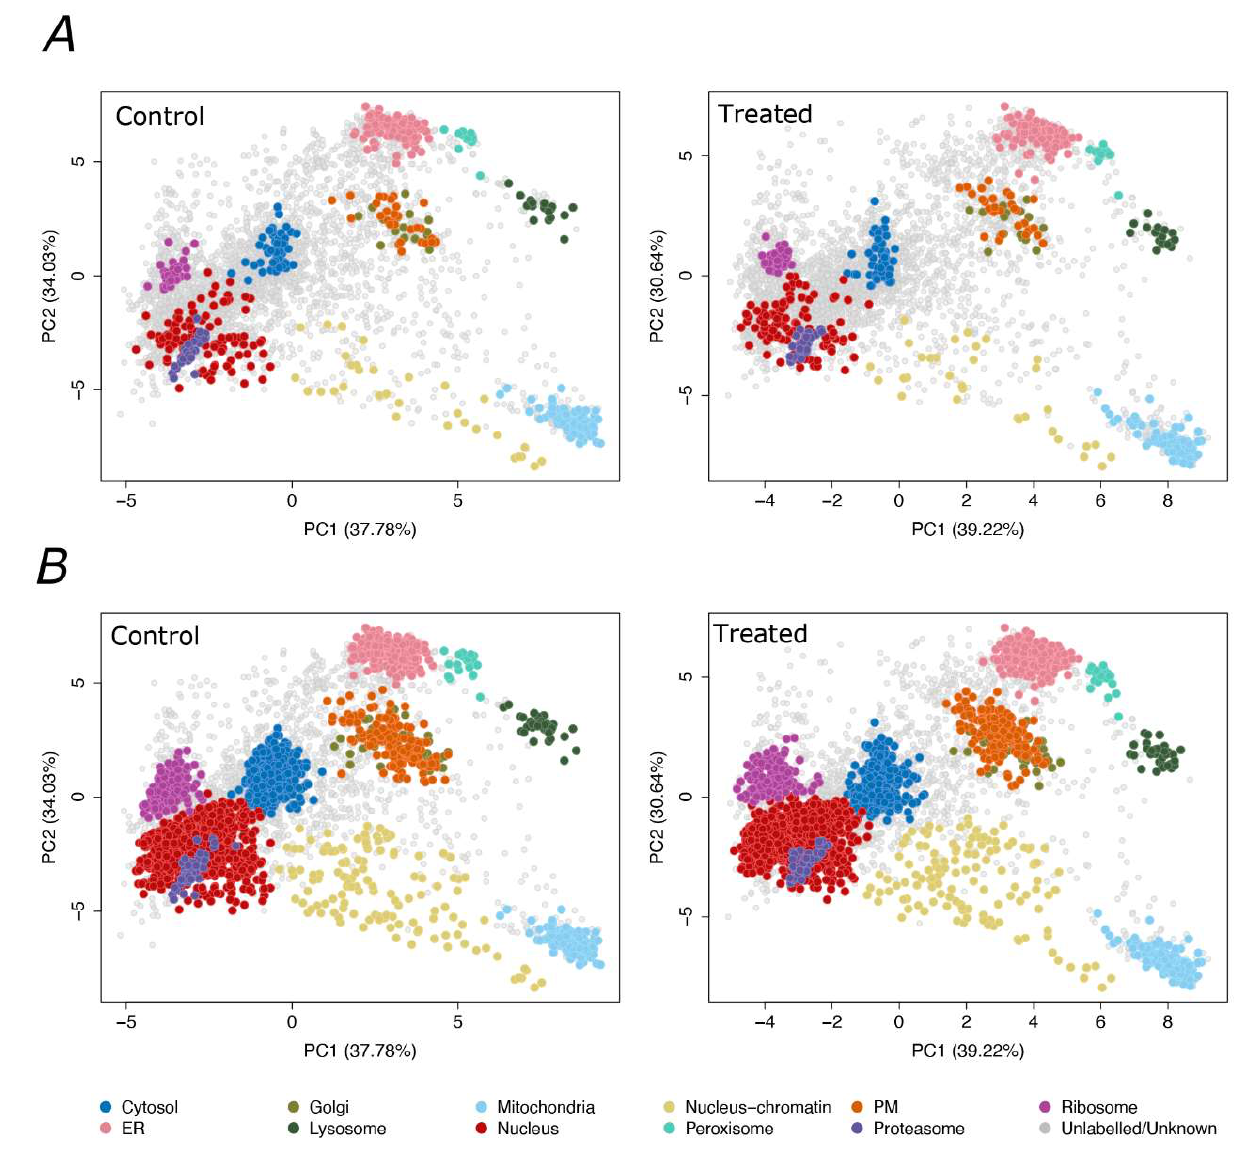
Figure 2. Subcellular maps of the F508del-CFTR CFBE41o- proteome. Each point corresponds to a single identified protein. ( A ) Principal component analysis (PCA) projections with subcellular marker proteins highlighted for 11 subcellular compartments (highlighted by different colours) in the control DMSO (left) and treated with VX-809 (right) experiments. ( B ) PCA plot of the Support Vector Machine (SVM) classification results after applying a 5% FDR cutoff; the proteins below the 5% FDR cutoff were classified as proteins with unlabeled/unknown localization.